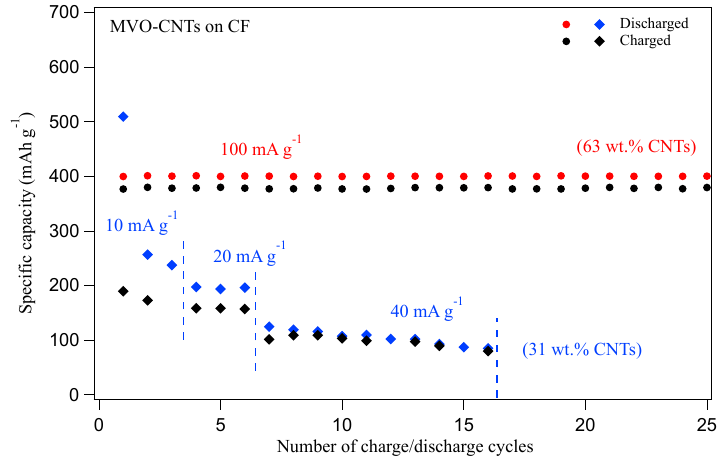
Figure 1. The specific capacity versus galvanostatic charge/discharge cycles at different current density values for the MVO-CNTs with 63 wt.% and 31 wt.% of CNTs electrodes, respectively. The MVO-CNTs electrode with 63 wt.% of CNTs sample data are taken from the Ref. [27]. From our previous results, an optimized wt.% using the charge and mass associ- ated with electrodeposition method incorporation with CNTs previously grown by